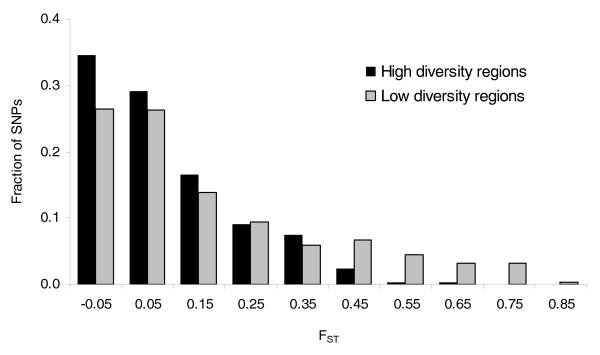
Distribution of Thailand-Senegal divergence (FST), plotted separately for markers in low diversity (SNP π < 0.005) and high diversity (SNP π > 0.005) windows. Window size is 20 kb.